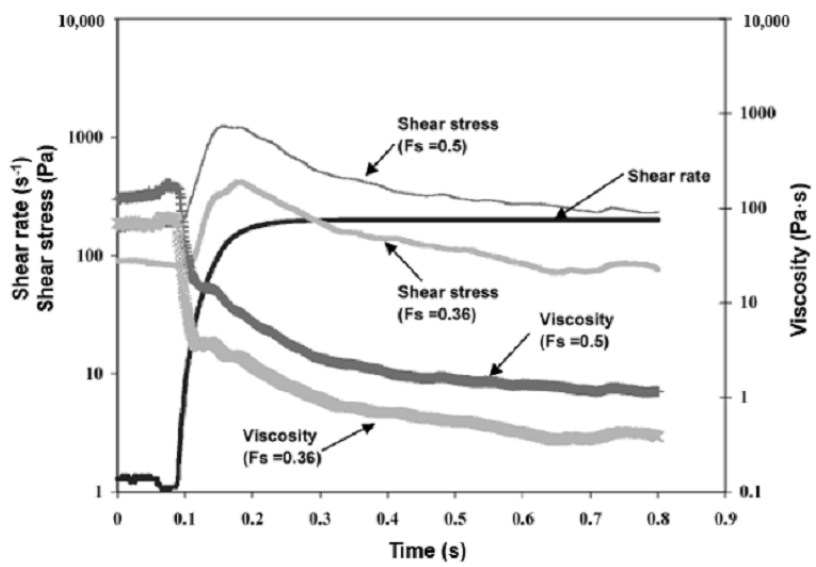
Figure 12. Shear rate jumps (1–200 s − 1 ) for Sn15Pb alloy for two different solid fractions ( Fs = 0.5 and 0.36) in isothermal condition